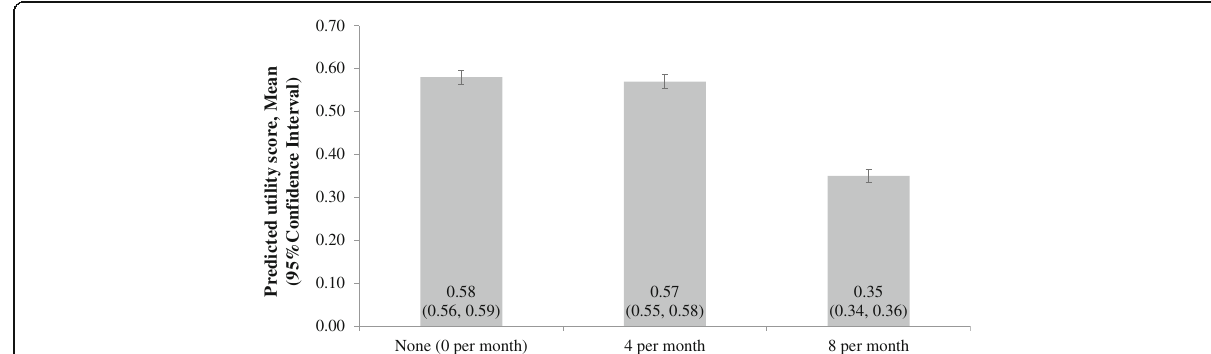
Fig. 4 Predicted utility with different frequency of transfusion ( N = 30) a . Abbreviation: CI, Confidence Interval. Note: a. The predicted utility score was estimated using estimates from a generalized linear model with logit link and binomial distribution for the error term and assuming scenarios where all treatment alternatives required 0, 4, and 8 transfusions per month, respectively. Analyses were performed using SAS